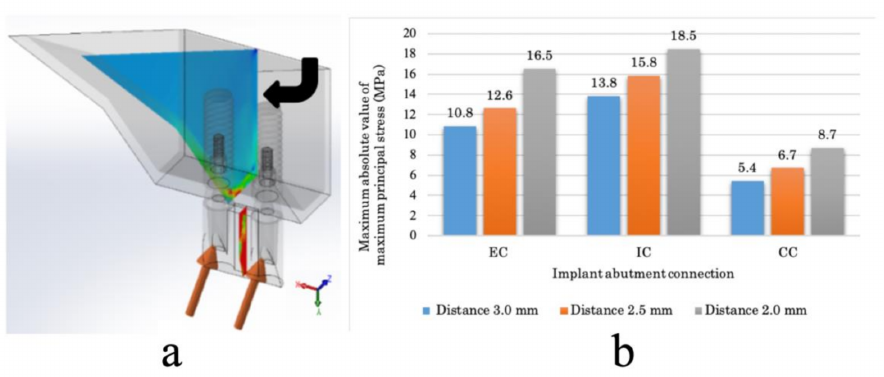
Figure 6. Stress value of the inter-implant bone. ( a ) Buccolingual plane in the midline of the inter- implant bone (black arrow). ( b ) Maximum value of the maximum principal stress of the inter-implant bone in each model. EC: external connection; IC: internal connection; CC: conical